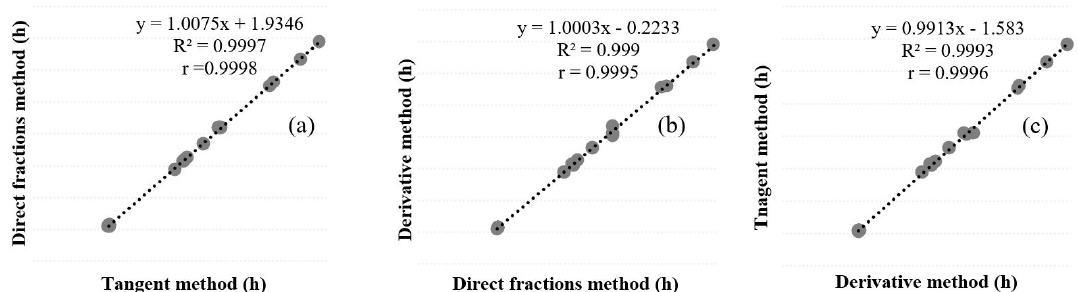
Figure 10. Correlation between the initial setting times obtained by the tangent, direct fraction, and derivatives methods, for mortars with cement F and cement Z.